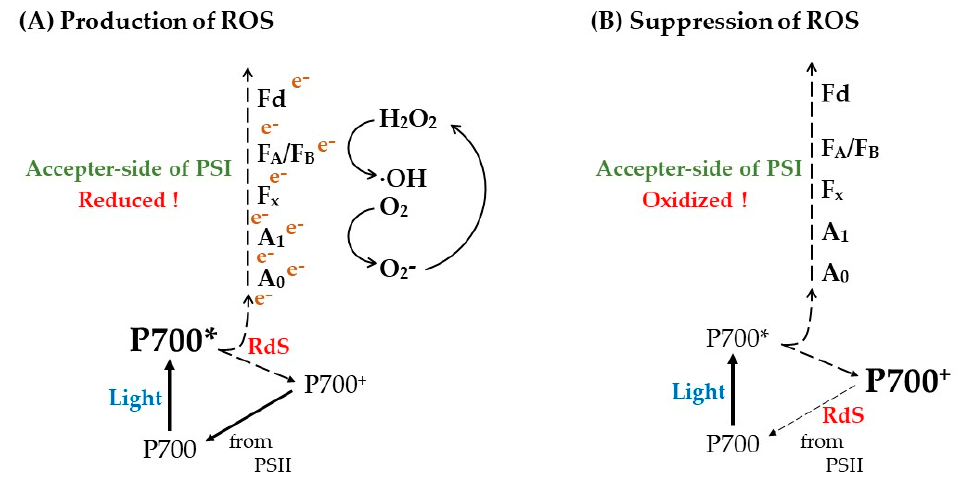
Figure 6. Production and suppression mechanism of ROS in PSI. PSI catalyzes the photosynthetic electron transport through a photo-oxidation reduction cycle in the reaction center of P700. P700 is photo-excited to P700* by the absorbed light energy and donates electrons to the primary electron acceptor chlorophyll a (A 0 ). P700 + accepts electrons from PSII through plastoquinol, Cyt b 6/ f -complex, and plastocyanin (PC), regenerating P700. The electron in A 0 flows to ferredoxin (Fd) through phylloquinone A 1 and the iron-sulfur (4Fe-4S) clusters F x and F A /F B . The accumulation of P700 + under the constant photon flux density is determined by the rate-determining step (RdS) of the production-consumption rate of P700 + in the photo-oxidation reduction cycle of P700 in PSI. At the RdS of P700*, oxidation P700 + does not accumulate; at the RdS of P700 + reduction, P700 + accumulates. ( A ) The RdS of P700* oxidation is caused by the accumulation of electrons at the acceptor-side of PSI, as observed with the reduction of Fe/S clusters (Fe/S − ), including F x , F A /F B , and Fd, where the possibilities of the reduction of phylloquinone A 1 also increase. These accumulated electrons would flow to O 2 to produce superoxide radical (O 2 − ), and O 2 − would degrade F X and F A /F B with the release of Fe and hydrogen peroxide (H 2 O 2 ). Both H 2 O 2 and the reduced Fe further react to produce hydroxyl radical (OH) through Fenton reaction. This highly reactive oxygen species (ROS) would oxidatively degrade PSI irreversibly, leading to PSI inactivation. ( B ) The RdS of P700 + reduction is caused by the limitation of photosynthetic electron transport from plastoquinol to P700 through Cyt b 6/ f -complex and PC [46,48]. Even under low photosynthesis efficiency conditions (drought, high intensity light, low/high temperature, low CO 2 , etc.), P700 is oxidized to P700 + . The RdS of P700 + reduction is induced by the acidification in the luminal side of thylakoid membranes, which suppress the oxidation activity of plastoquinol by the Cyt b 6/ f -complex, with the oxidation of the electron acceptors A 0 , A 1 , F X , F A /F B , and Fd, leading to the suppression of ROS production. This is the physiological function of P700 oxidation to suppress ROS production in PSI.